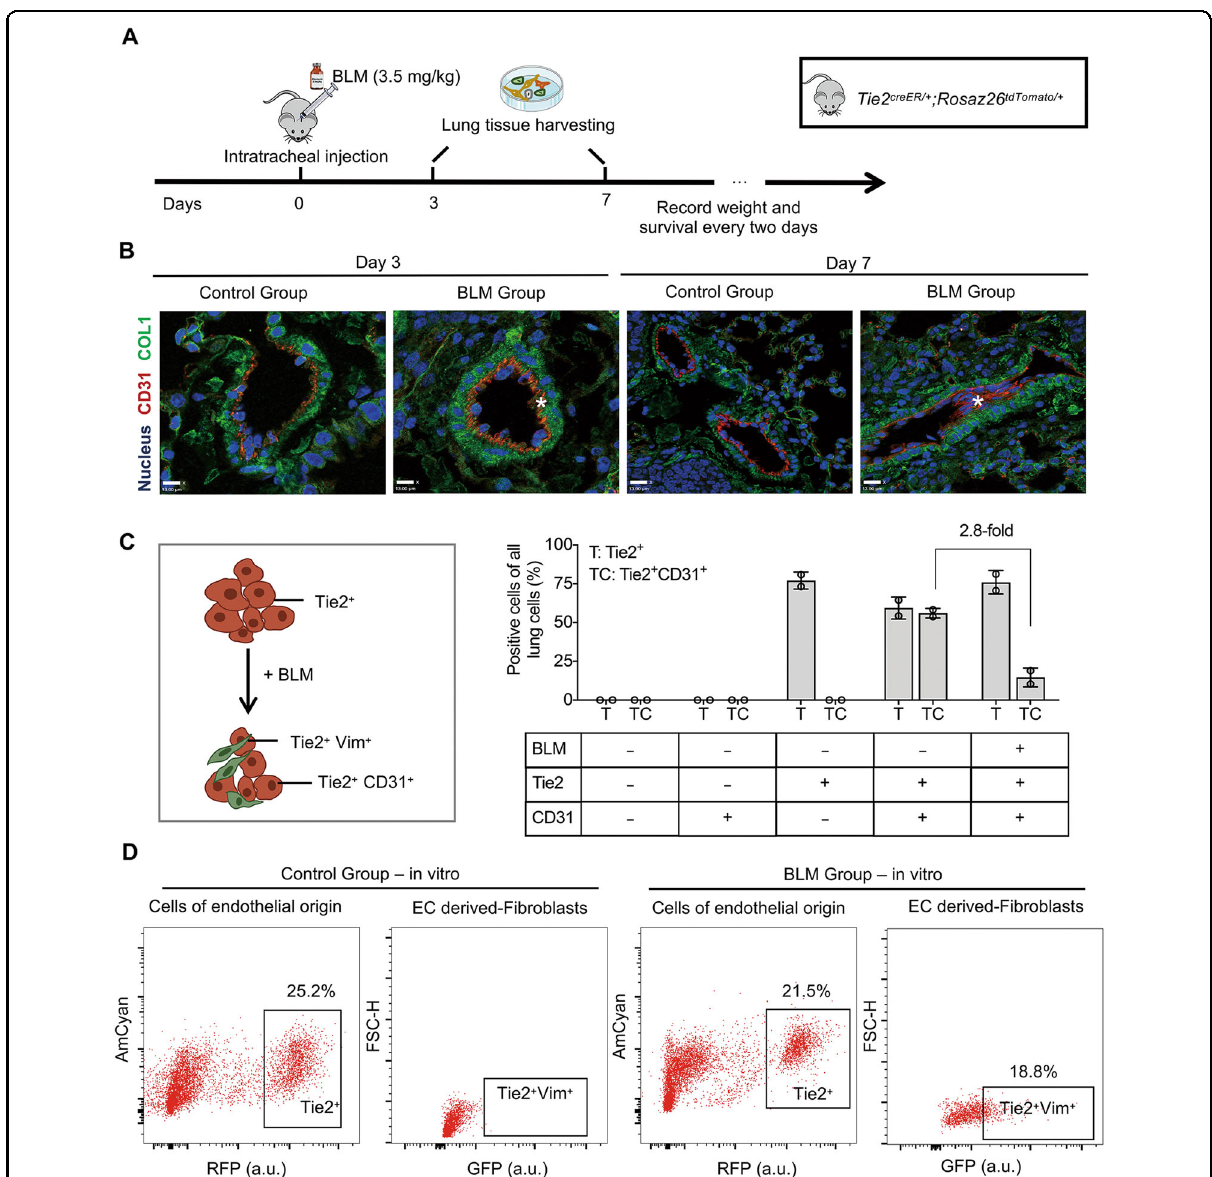
Fig. 1 Veri fi cation of EndMT in a mouse model of pulmonary fi brosis. A Schematic diagram of the construction of the IPF model in Tie2 creER/ + ; Rosa26 tdTomato/ + mice based on a C57bl/6 genetic background. B Immuno fl uorescence imaging of ECs ( CD31 , red) and fi broblasts (COL1, green) in the BLM/control groups. The region in blue represents nucleus. Asterisks indicate the co-localization of ECs and fi broblasts. Scale bar = 13 μ m. C Comparative analysis of the relative proportions of EC-derived cells ( Tie2 + ) and ECs ( Tie2 + CD31 + ) in the BLM/control groups presented as means ± SD, n = 2. x-axis: different mice derived from C57BL/6. Tie2 -positive cells represent all cells of endothelial origin; Tie2 + CD31 + cells represent resident ECs that remain endothelium-feature supplemented with BLM or saline solution. y-axis: the percentage of subpopulations of Tie2 -positive and Tie2CD31 -positive cells. n = 2. D Gating strategy for calculating the fraction that underwent EndMT ( Tie2 + Vim + ) cultured in vitro for 72 h after isolation from lungs by PBS perfusion. Speci fi cally, cells gated by rectangles in black are subpopulation of